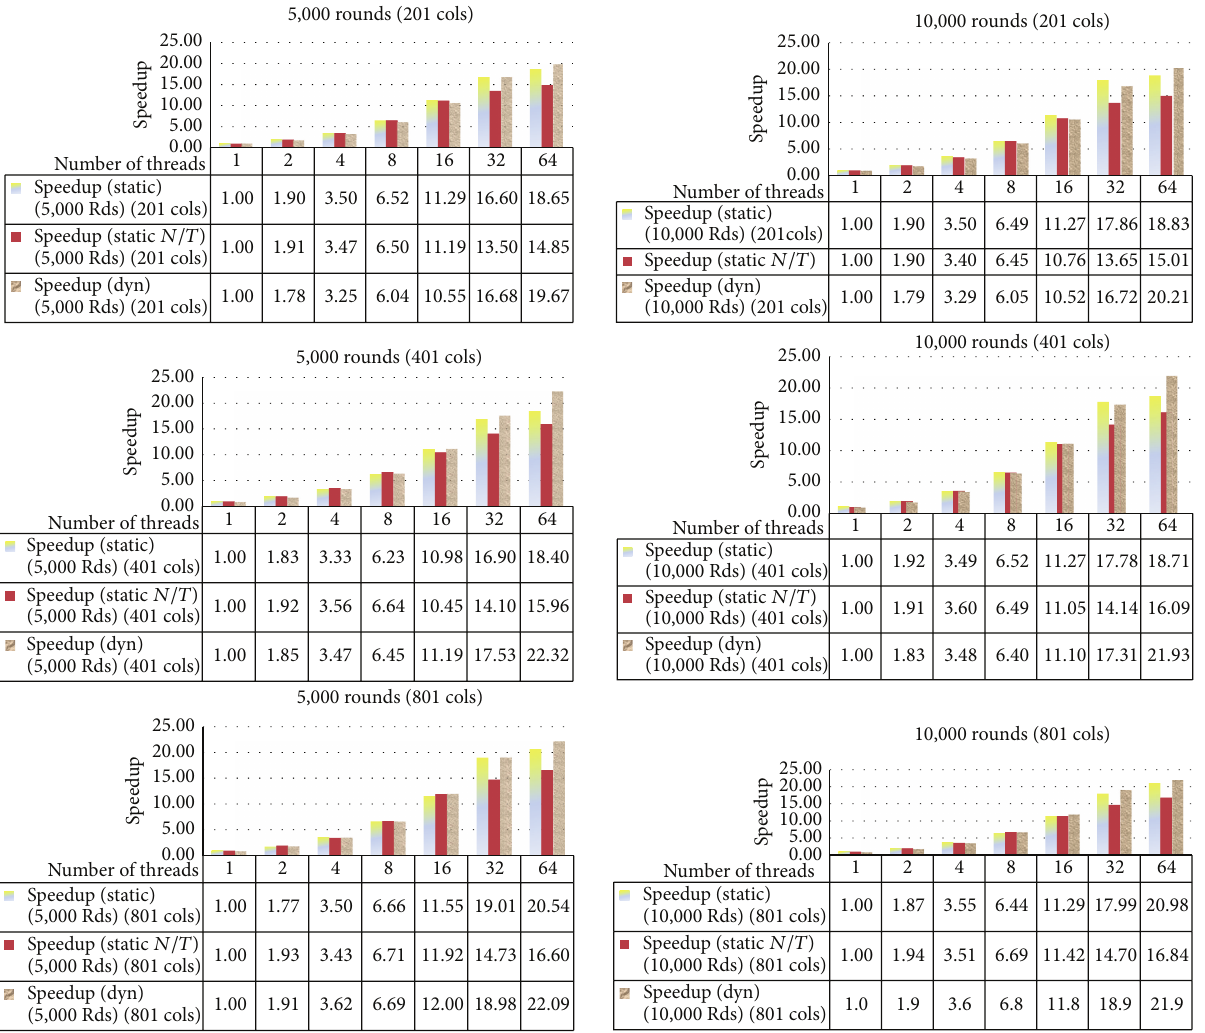
Figure 7: The speedup for the varying number of columns, 201, 401, and 801, and varying number of iterations, 5,000 and 10,000 iterations, varying schedule